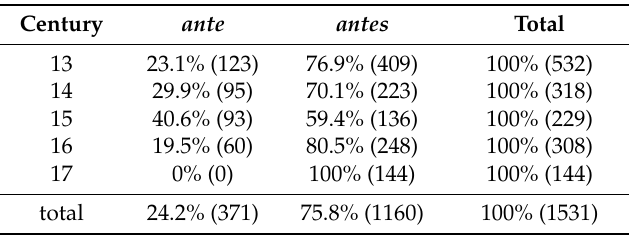
Table 1. Frequencies of ante and antes per